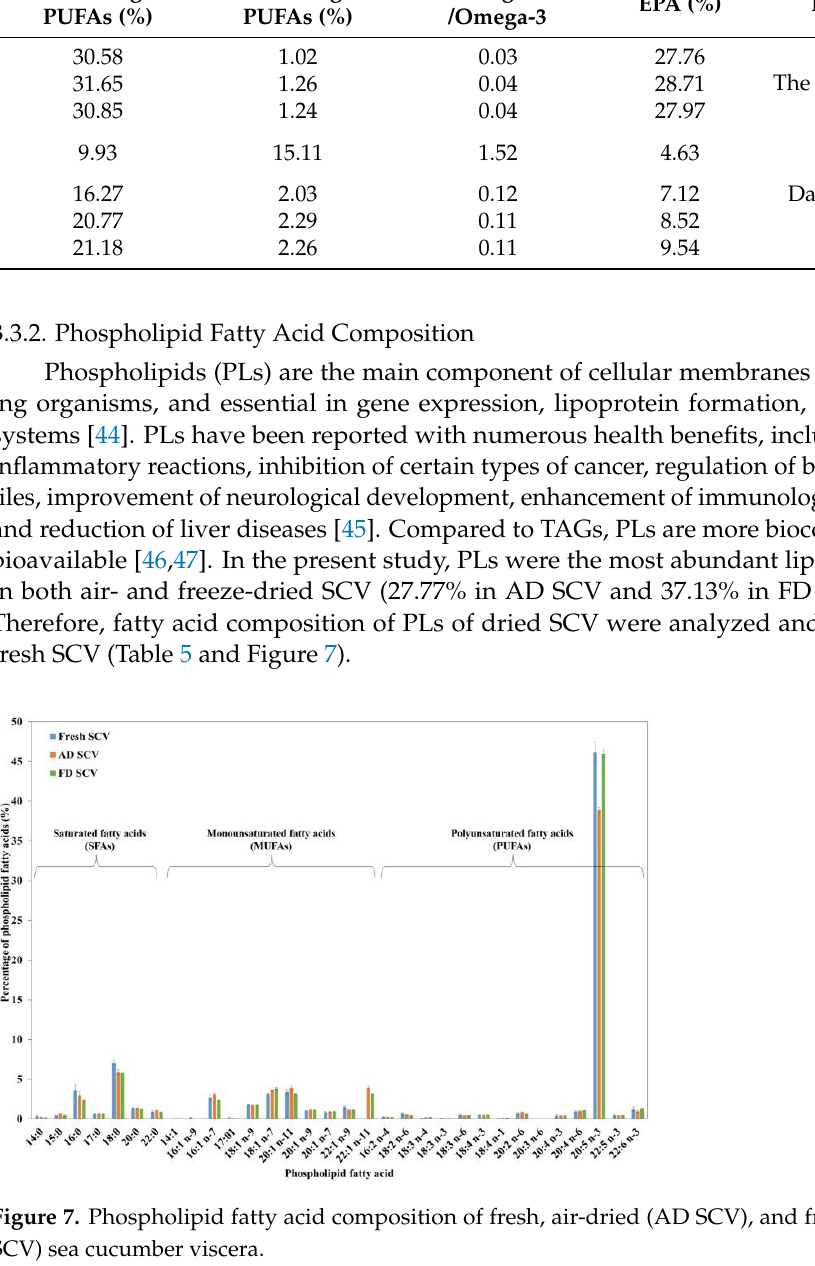
Table 5. Phospholipid fatty acid composition of fresh, air-dried (AD SCV), and freeze-dried (FD SCV) sea cucumber vis- cera.